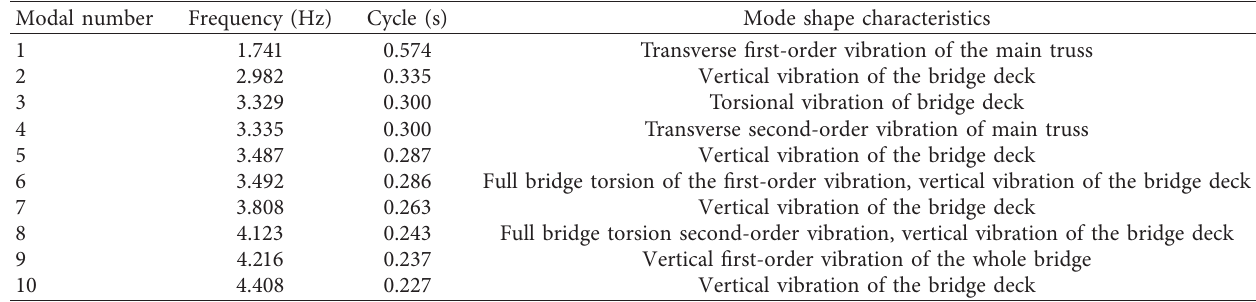
Table 1: The first 10-order natural vibration characteristics of the bridge before reinforcement.